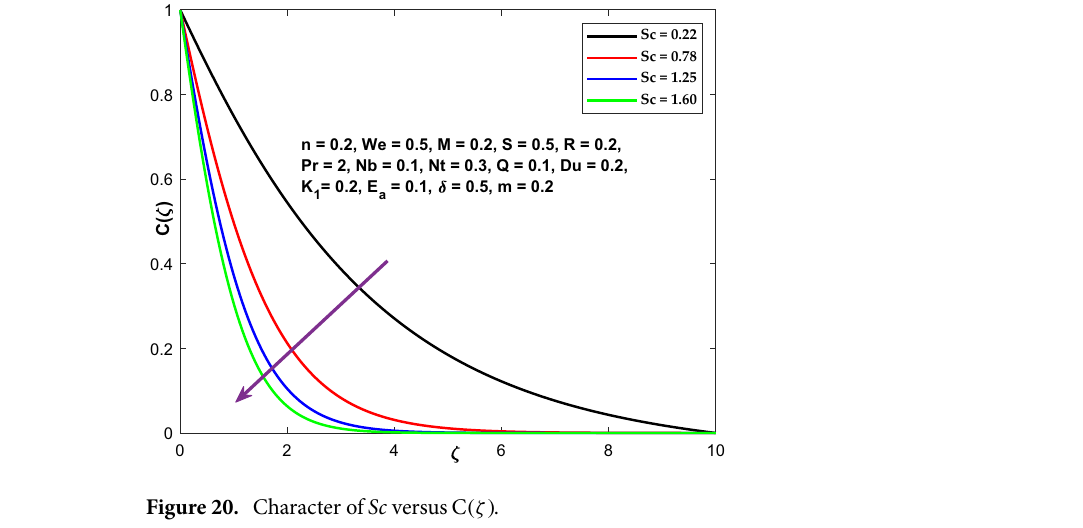
Figure 20. Character of Sc versus C (ζ) .